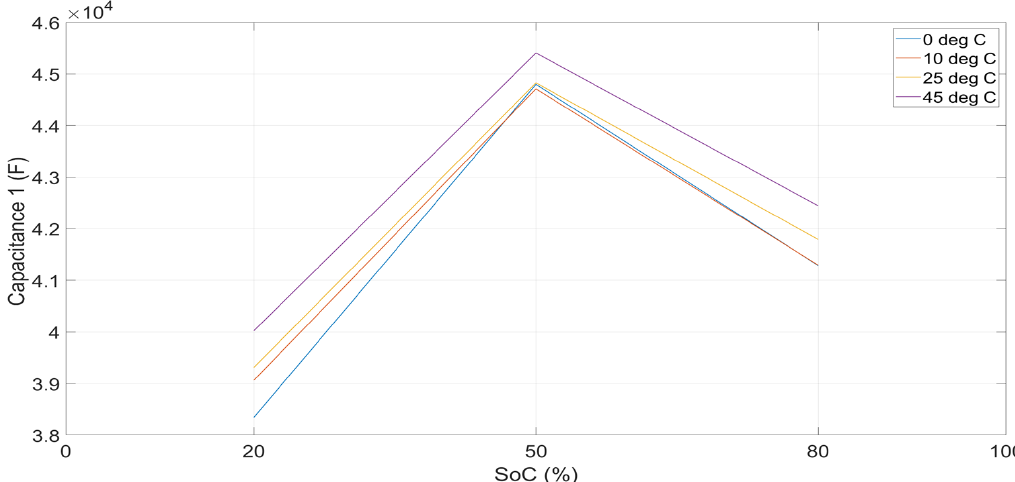
Figure 6. Polarization resistance 2 as a function of temperature and state of charge.